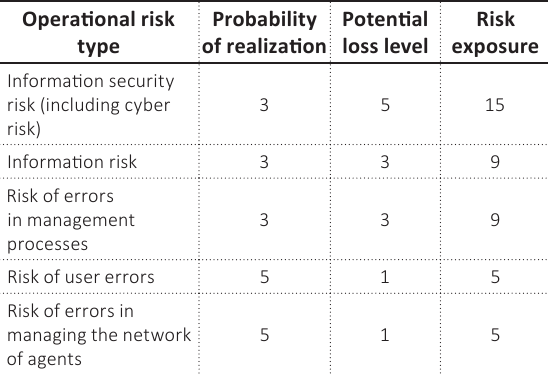
Table 5. Estimation of realization probability, potential loss levels and risk exposure as a result of the impact of certain types of EMI activities’ operational risk